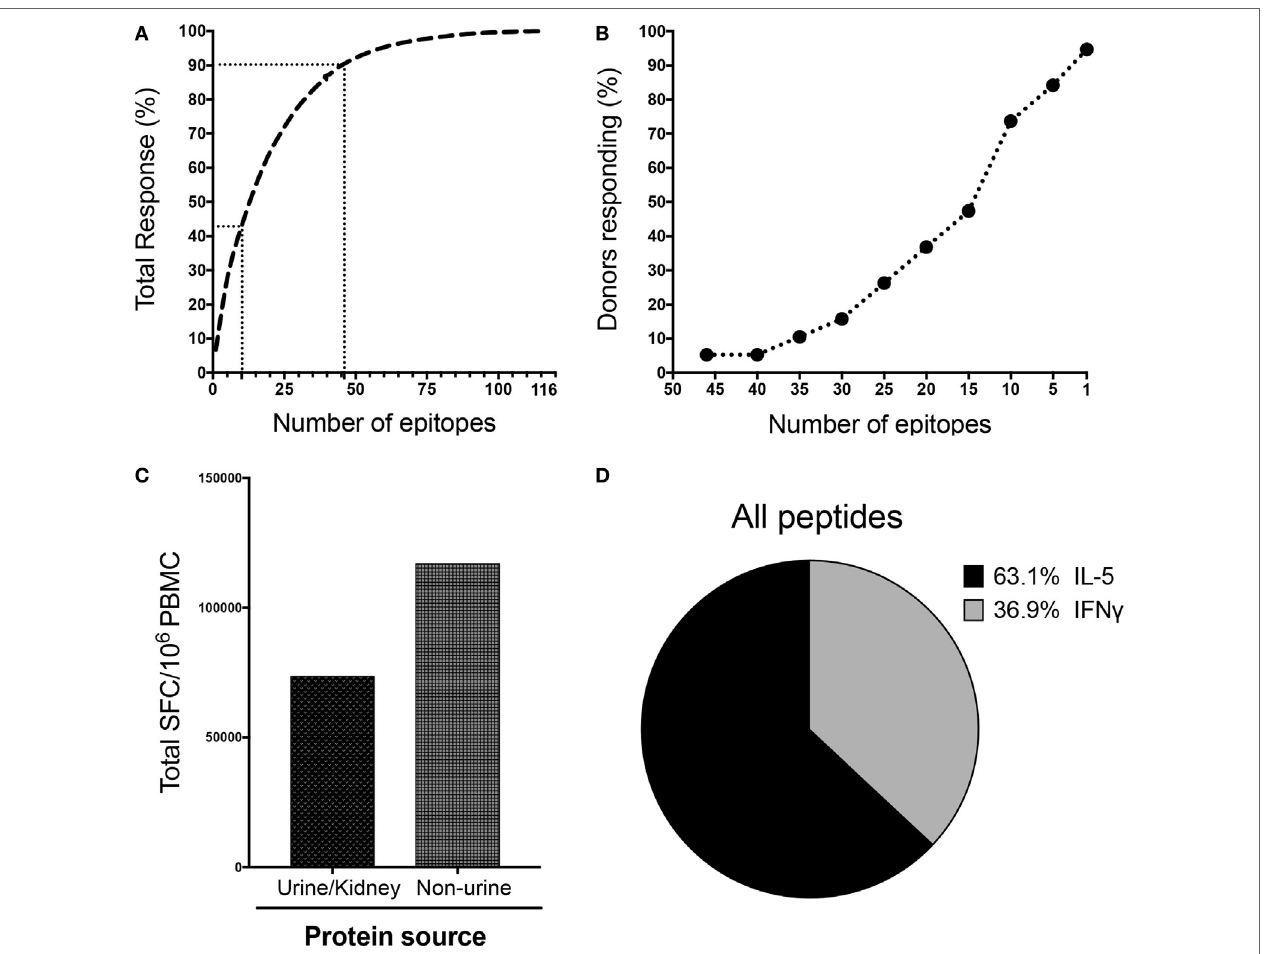
FigUre 3 | LoMo immunodominance, protein source, and response polarization. (a) Epitopes ranked on the basis of magnitude of response. Dotted lines indicate the top 10 (42.6% of total response) and top 46 (90% of total response) epitopes. (B) Breadth of response indicated by proportion of donors who respond to the specified number of epitopes. (c) Total spot-forming cells (SFC) detected against peptides from urine/kidney or non-urine protein sources. (D) Pattern of cytokine production expressed as proportion of IFN γ or IL-5 for all the reactive